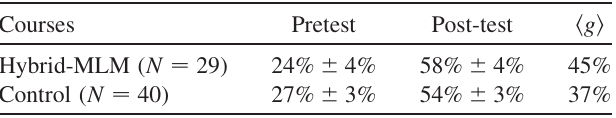
TABLE I. Pretest and post-test scores (with their relative stan- dard errors) as well as normalized gains on the CSEM.